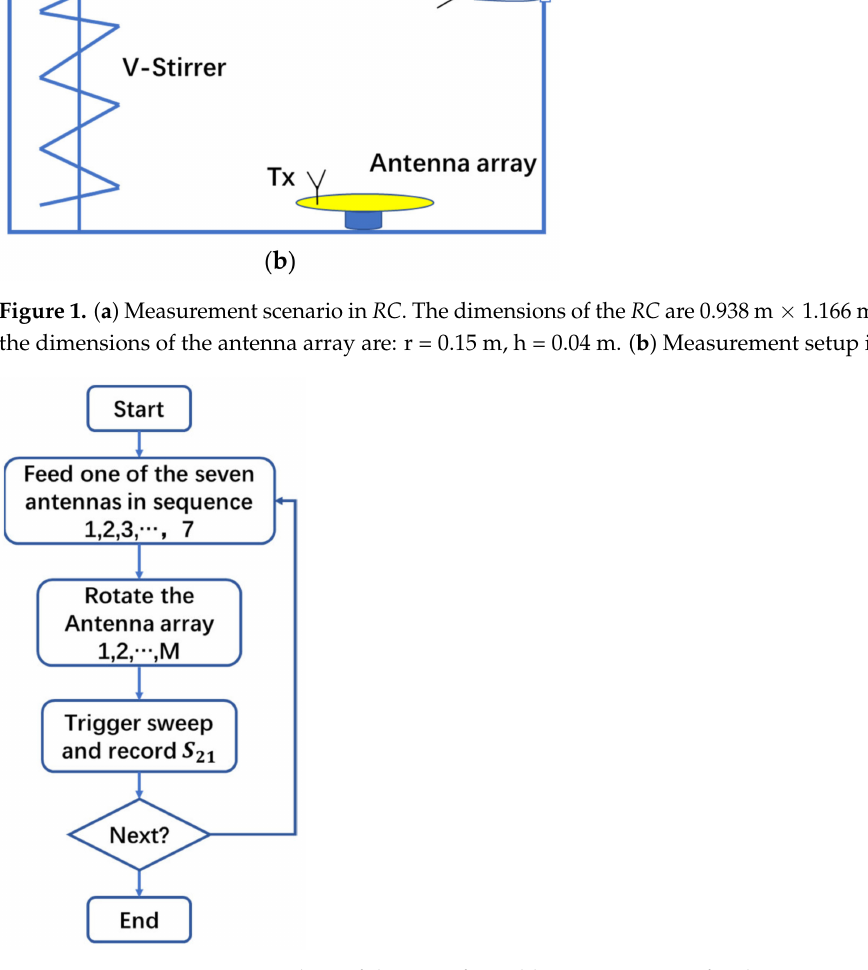
Figure 2. Measurement procedure of the reconfigurable source stirring for the antenna